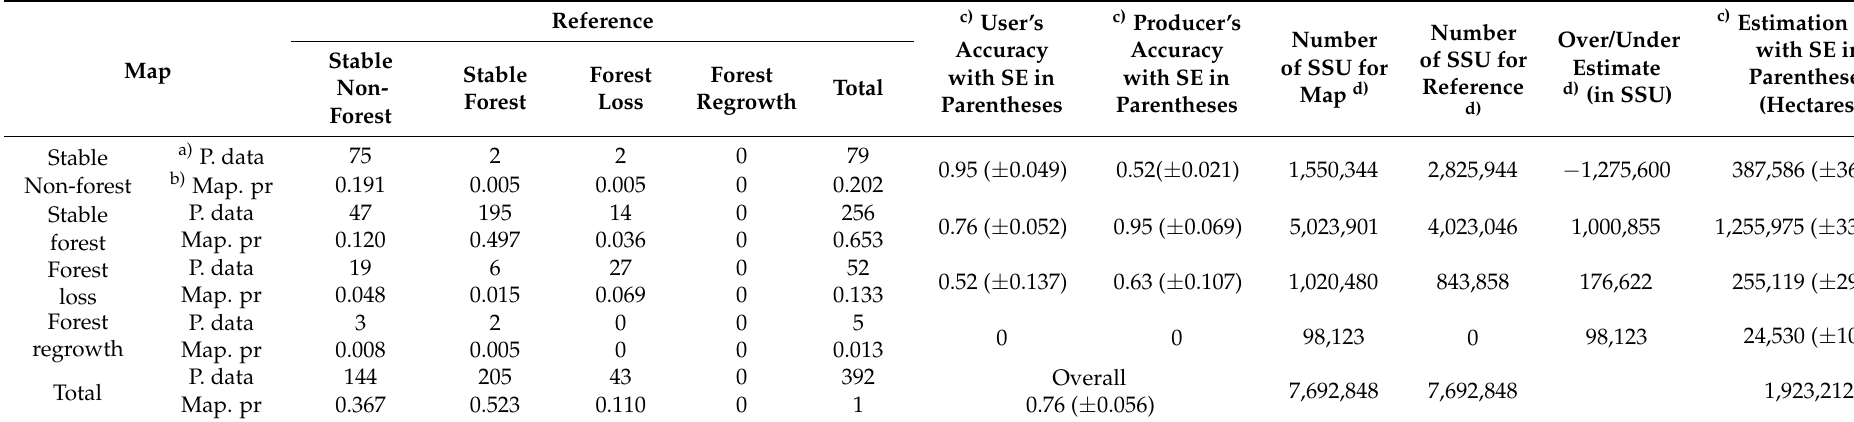
Table A1. Description of population data and map proportion area confusion matrix for the automated digital processing of land cover change map in 2000–2006.